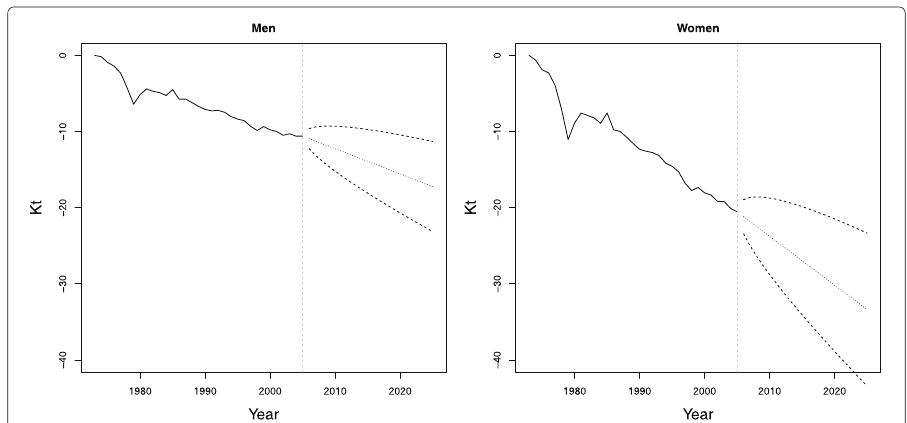
Fig. 7 Prediction of the period index of the LC models for the period 2006–2025, Colombia. Dashed lines represent central forecasts, and dotted lines represent 95% prediction intervals will have an increase of 7 years from 71 years, and women will experience an increase of 8 years from 76 years. Women will have a higher life expectancy than men (6 years more), thus maintaining the tendency to live longer.